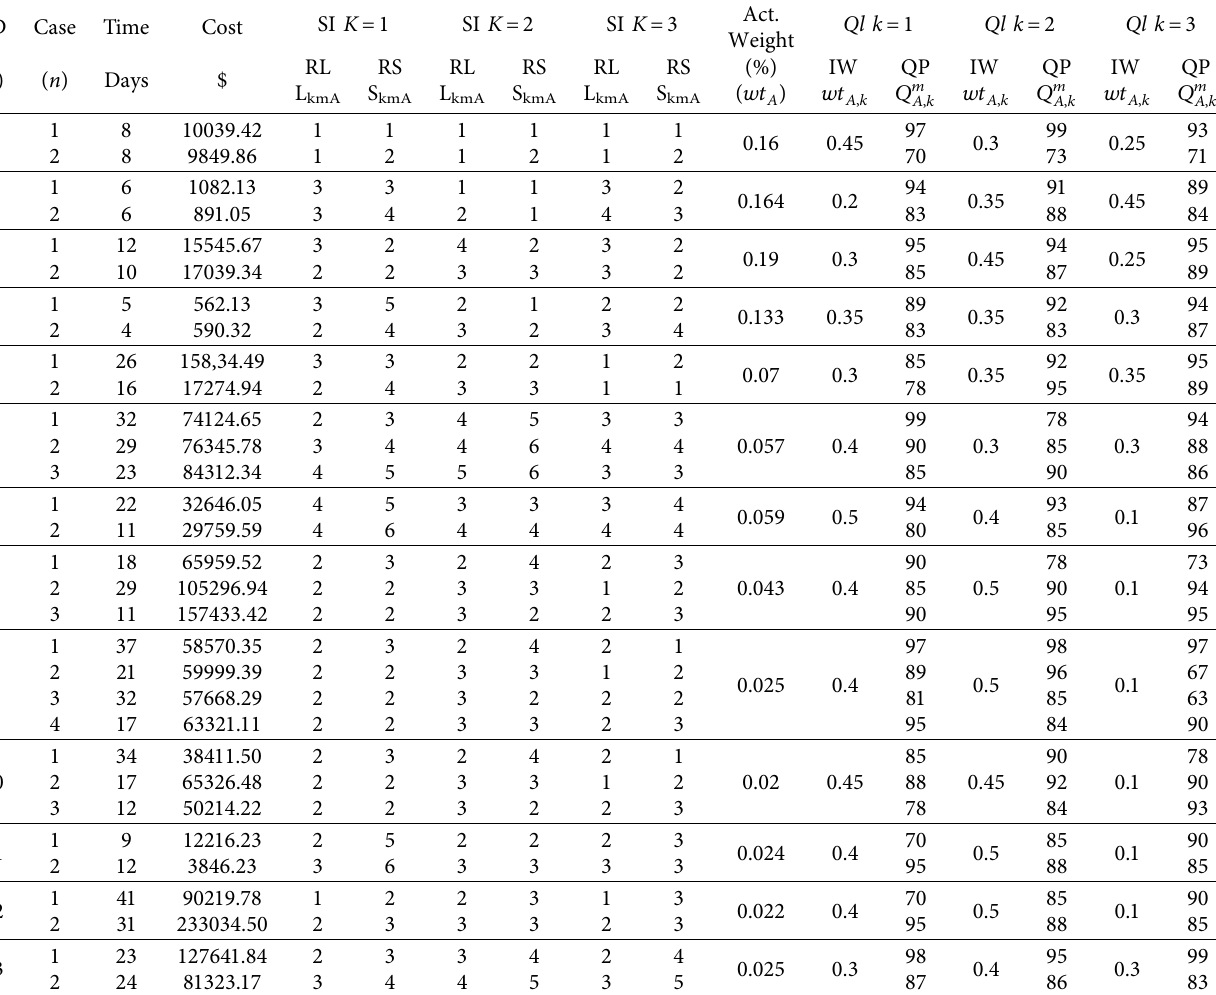
Table 2: Data resources for case